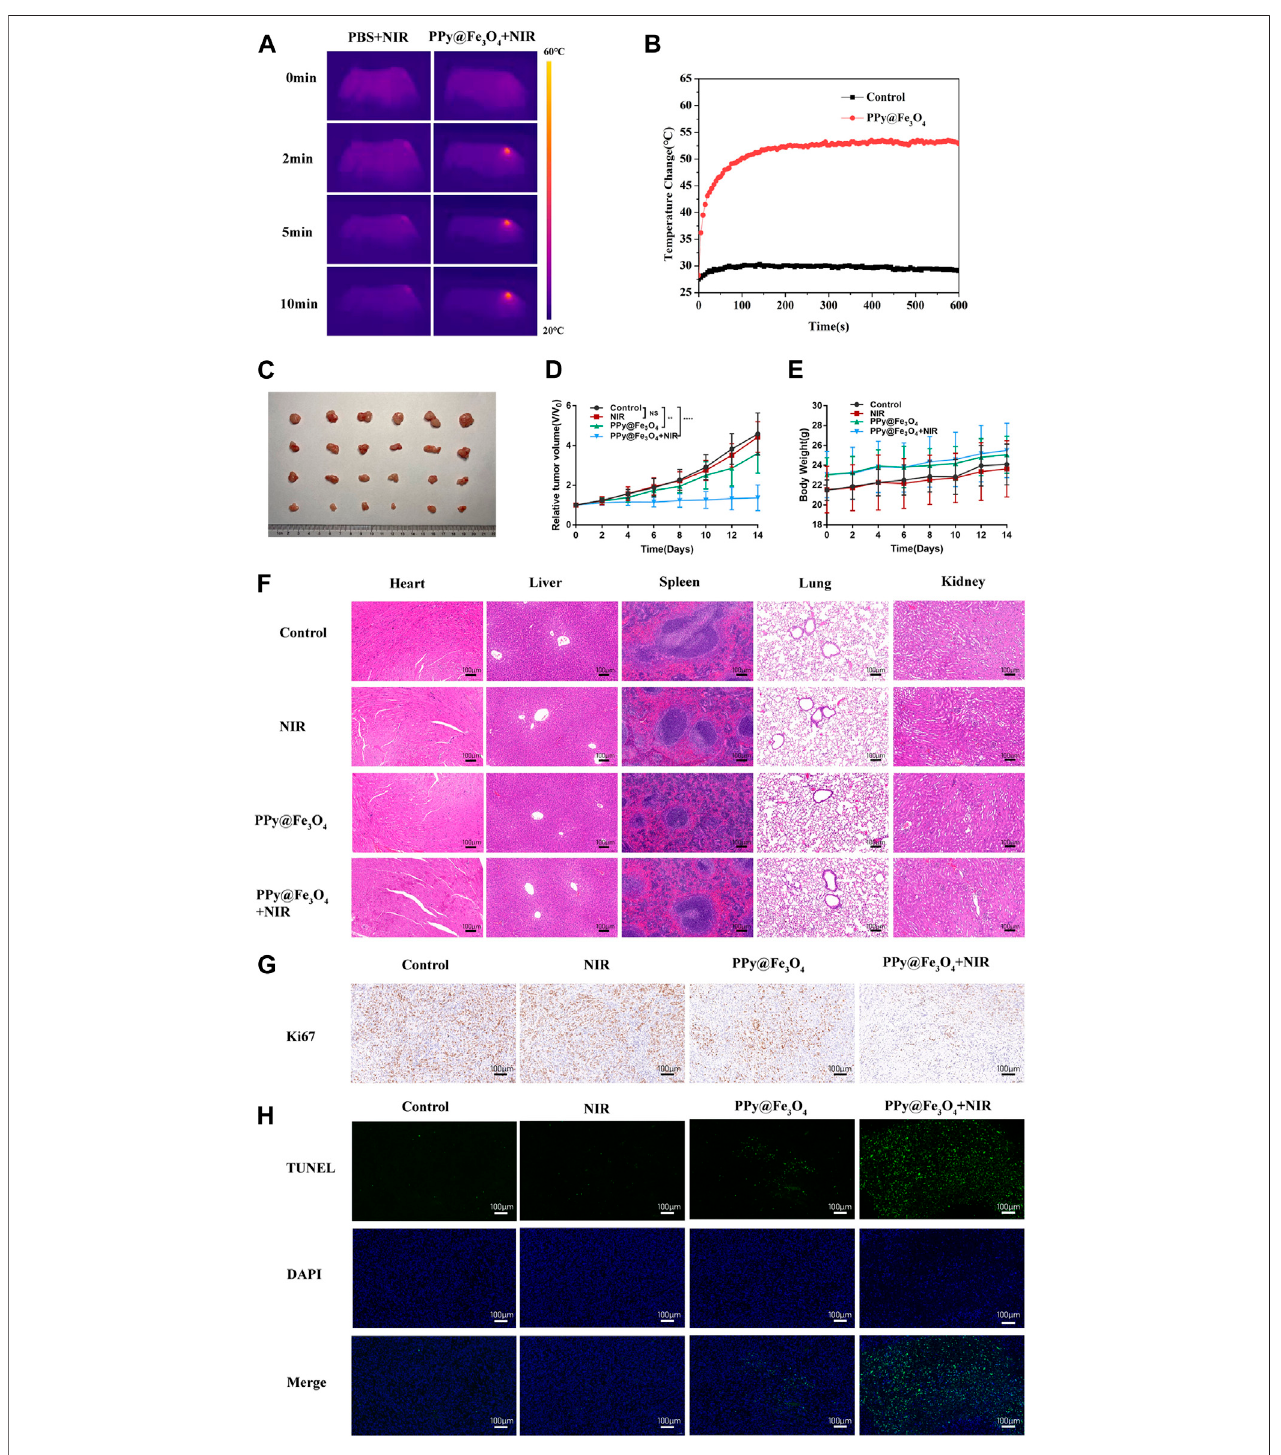
FIGURE6| ThePPy@Fe 3 O 4 NPsinhibitthegrowth oftumor xenograftsinnudemice. (A) Infrared thermography picturesofA549tumor-bearingmicetreatedwith PBS and PPy@Fe 3 O 4 NPs under irradiation (808 nm, 1.0 W/cm 2 ). (B) Pro fi le of temperature variation of the tumor areas. (C) Tumor photo excised on day 14 after treatments. (D) Relativetumorvolumeand (E) bodyweightofmiceindifferentgroups. (F) H&Estainingofmainorganscollectedfrommiceindifferentgroups.Scalebar, 100 μ m. (G) Representative immunohistochemical stain images for Ki67 in xenograft tumors. Scale bar, 100 μ m. (H) Representative TUNEL stain images in xenograft tumors. Blue color: DAPI staining for cell nuclei. Green color: positive apoptotic cells. Scale bar, 100 μ m.